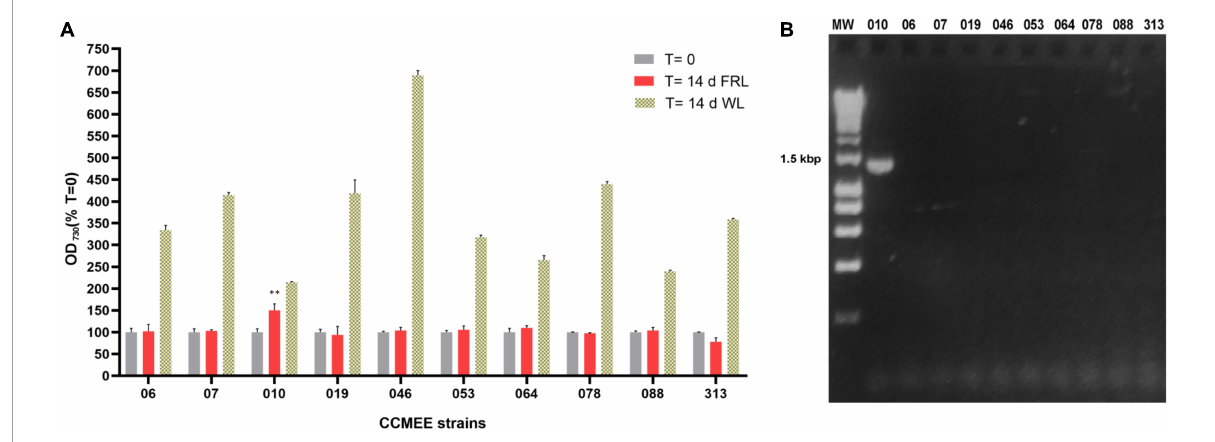
FIGURE1 Capacity for photosynthesis under far-red light in 10 desert Chroococcidiopsis strains. (A) Cell densities after 14-day incubation under WL or FRL; values at time zero are set as 100. All WL cultures showed a significant increase in OD 730 ( p -value < 0.001, not shown) after 14 days under FRL a significant increase in OD 730 occurred only in CCMEE 010 ( ∗∗ p -value < 0.01). (B) PCR amplification of the far-red apcE2 gene. MW, molecular weight (HyperLadder 1 kb, Bioline Inc., MA, United